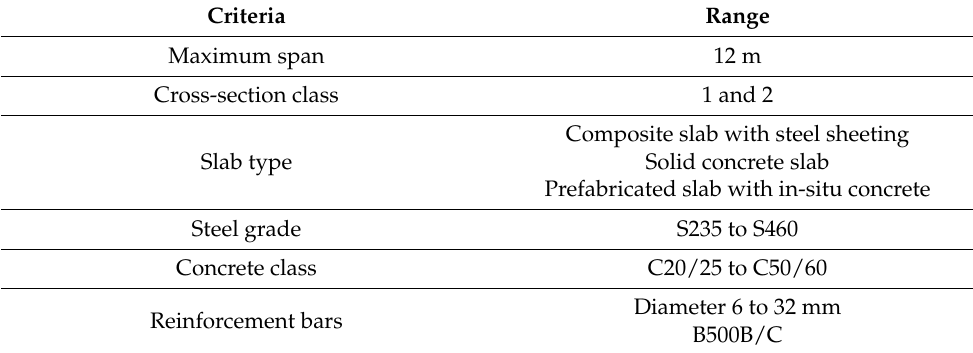
Table 1. Application range—general scope [21].